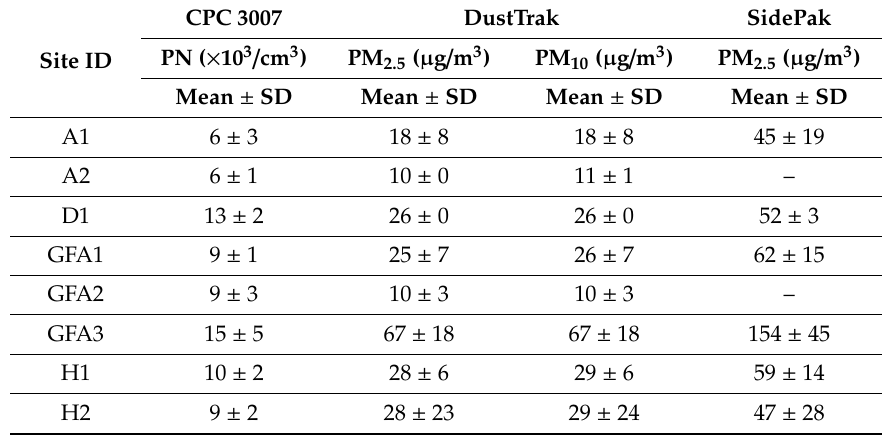
Table 6. Indoor particle number and mass concentrations (mean ± SD) during the nighttime, when there were no reported indoor activities. The concentrations were calculated for the winter campaign